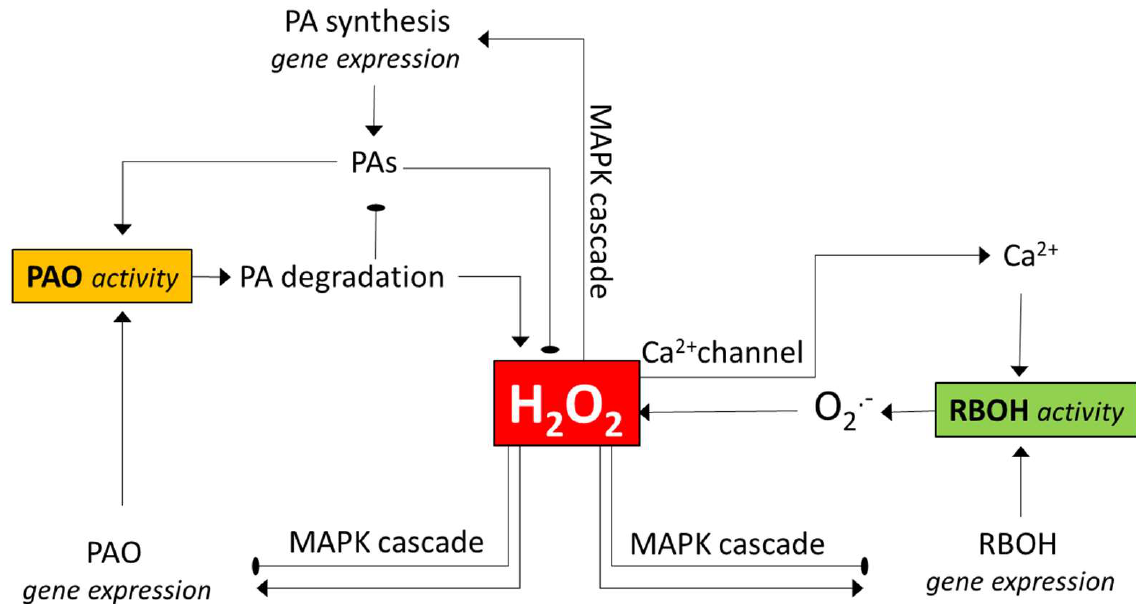
Figure 1. An outline of the pathways of how polyamine oxidase (PAO) and NADPH oxidase